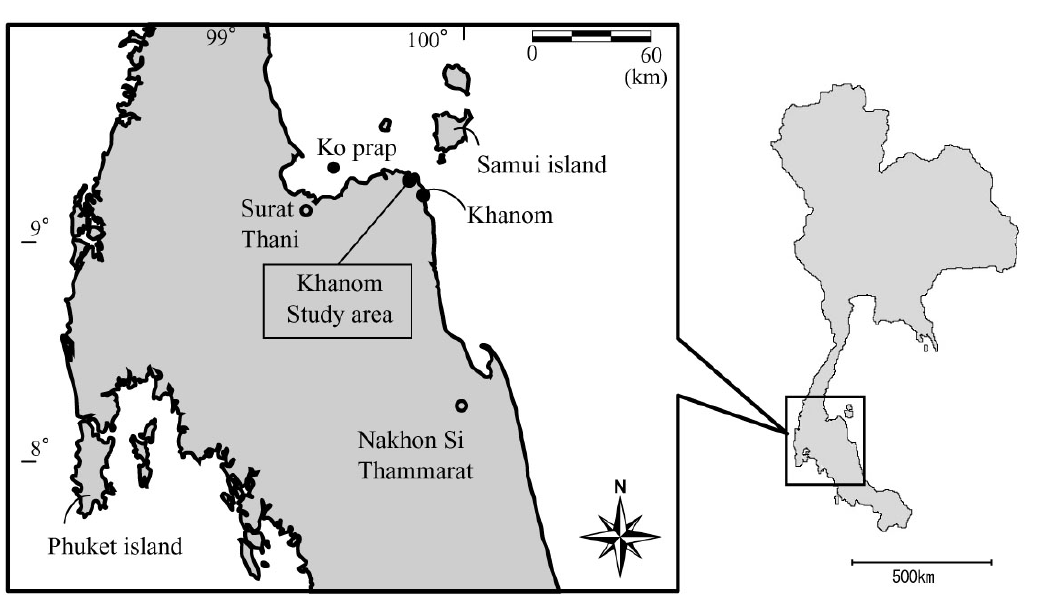
Figure 1. Location of the study site: Khanom, Nakorn Sri Thammarat province,